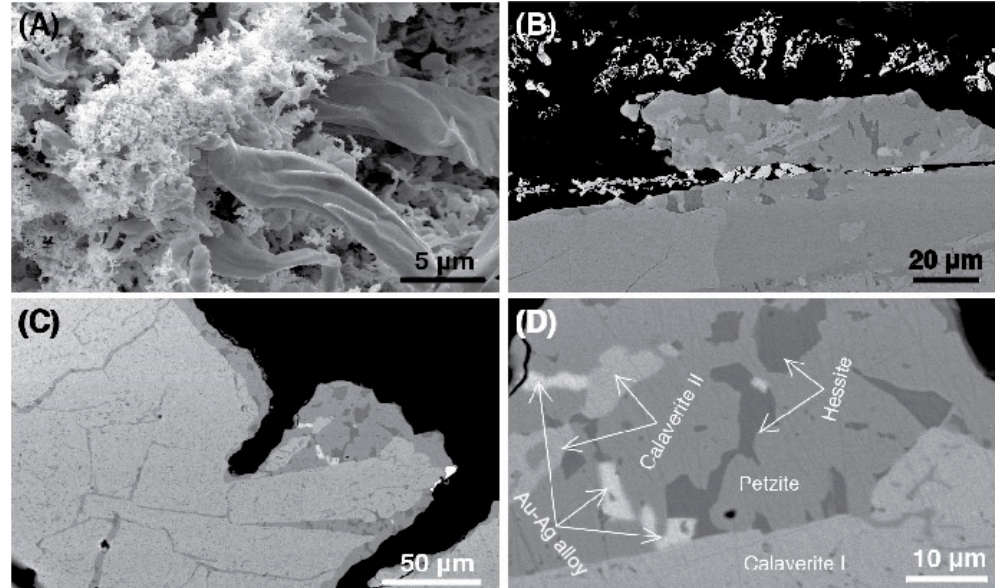
Figure 9. ( A ) Secondary electron images showing the micro Au–Ag alloy wires growing on the surface of a partially-reacted sylvanite grain. ( B , C ) Backscattered electron images of cross section of partially-reacted sylvanite grains showing a range of products after the replacement reaction. ( D ) Zoomed in image of Figure 9C, showing the textures of the calaverite II, petzite, hessite, and Au–Ag alloy; petzite and hessite occur intimately mixed either as small patches or inclusions within calaverite I.